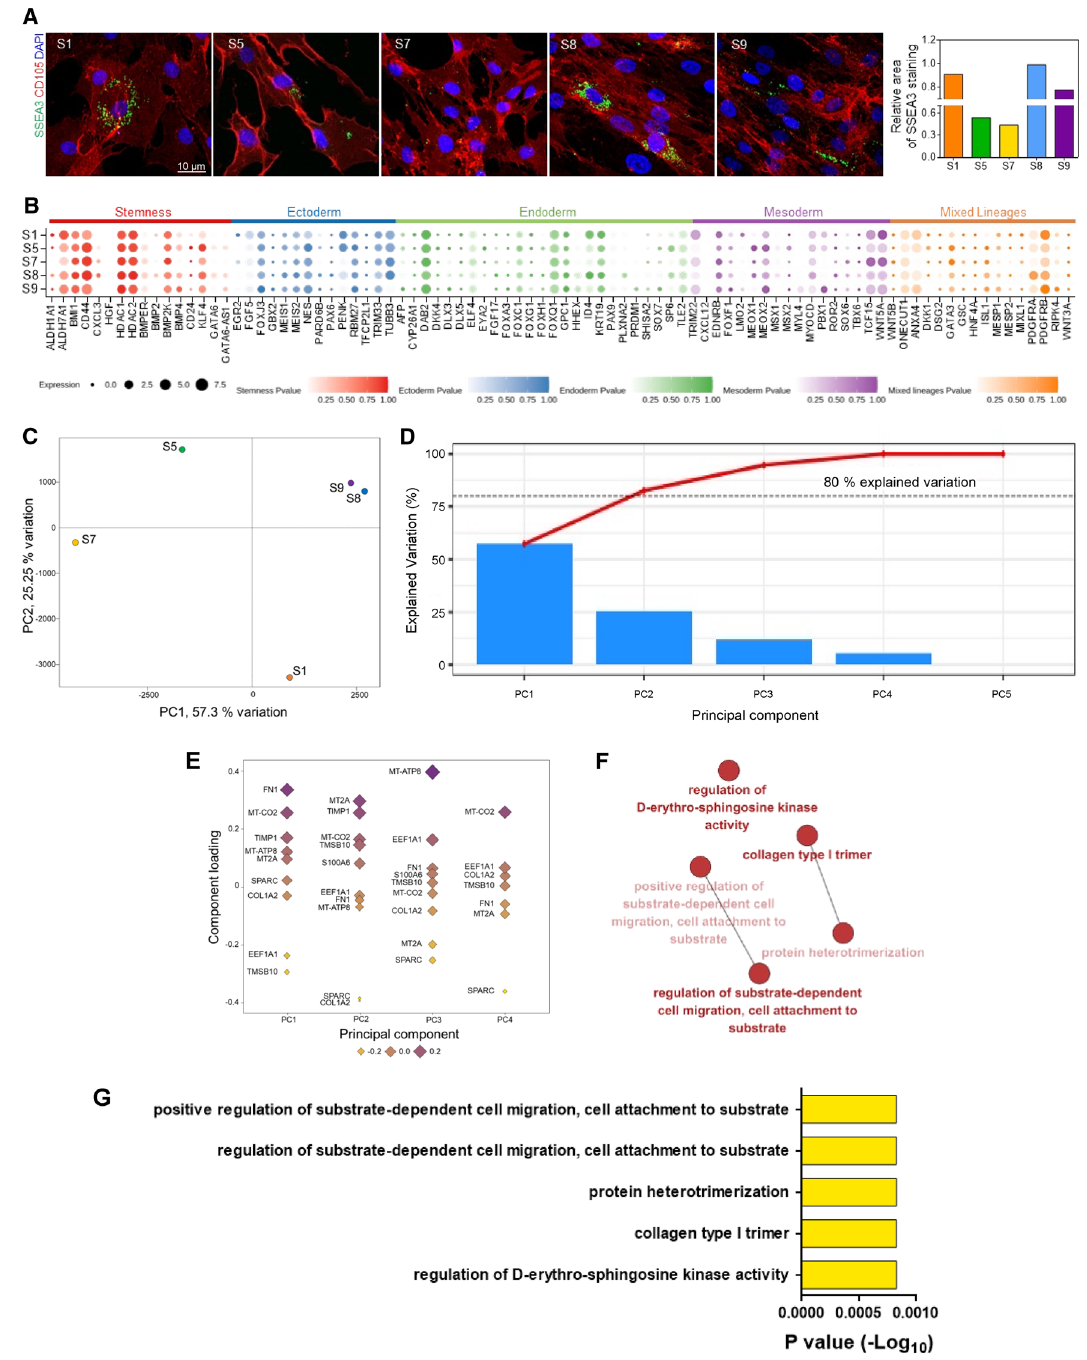
Figure 3. ( A ) Immunofluorescence images presenting a difference in the multipotency of hNTSCs from different donors. ( B ) Dot plot presenting expression of stemness-related genes within five different cells: the frequency of cells within a cluster expressing the gene of interest (dot size) and the level of expression of the gene (the degree of color intensity) are visualized. ( C ) Principal component analysis (PCA) and ( D ) scree plots for PCA. ( E ) PCA loading plot presenting the transformation factors of PCA. ( F ) Functional enrichment analysis visualized by each gene ontology (GO) term in which each node is linked according to a kappa score of ≥ 0.4. FDR.adj.p-value (FDR adjusted p-value). ( G ) Statistical significance and number of each GO term are presented via functional enrichment analysis. P-values were adjusted with